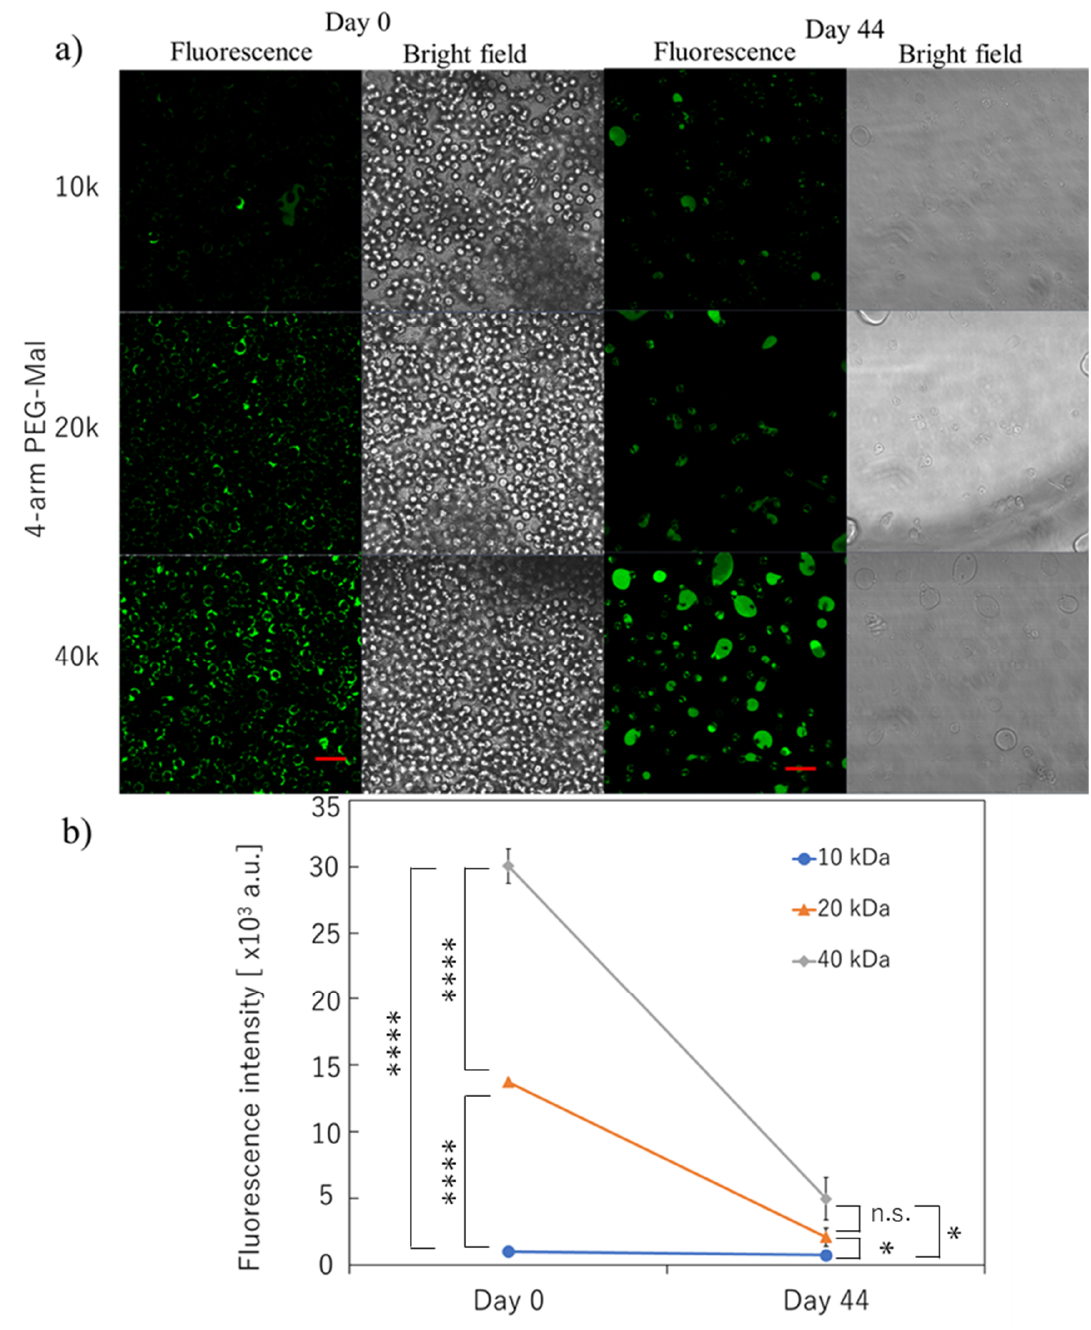
Figure 2. Microencapsulation of human erythrocytes with different 4-arm PEG-Mal. ( a ) Confocal microscopic images of microencapsulation of human erythrocytes with 4-arm PEG(10k, 20k, and 40k)-Mal. FITC-BSA-SH was used for the visualization of the polymer membrane. Scale bar: 20 µm. ( b ) Quantitative analysis of polymer membrane on human erythrocytes using flow cytometry at 0 and 44 days. Error bars indicate standard deviation; n = 3. * = p < 0.05; **** = p < 0.0001; n.s. = not significant.